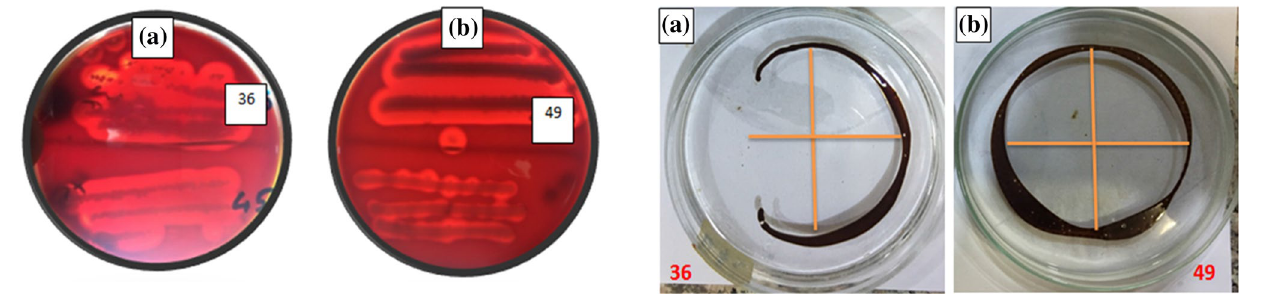
Fig. 7 Oil displacement test a −36, b